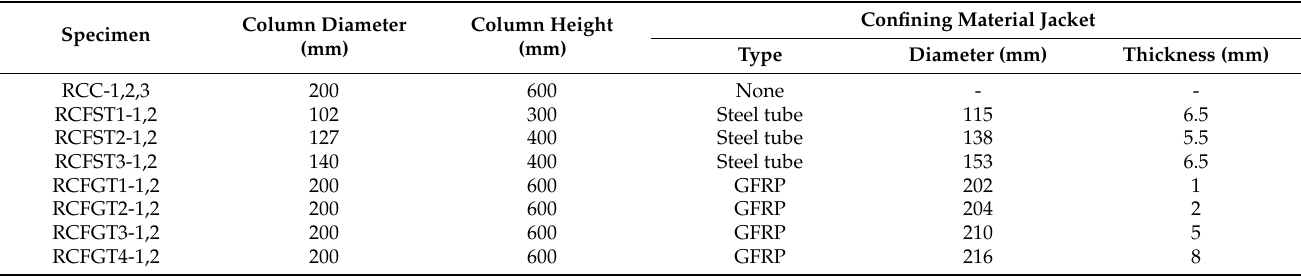
Table 8. The design sizes of all test